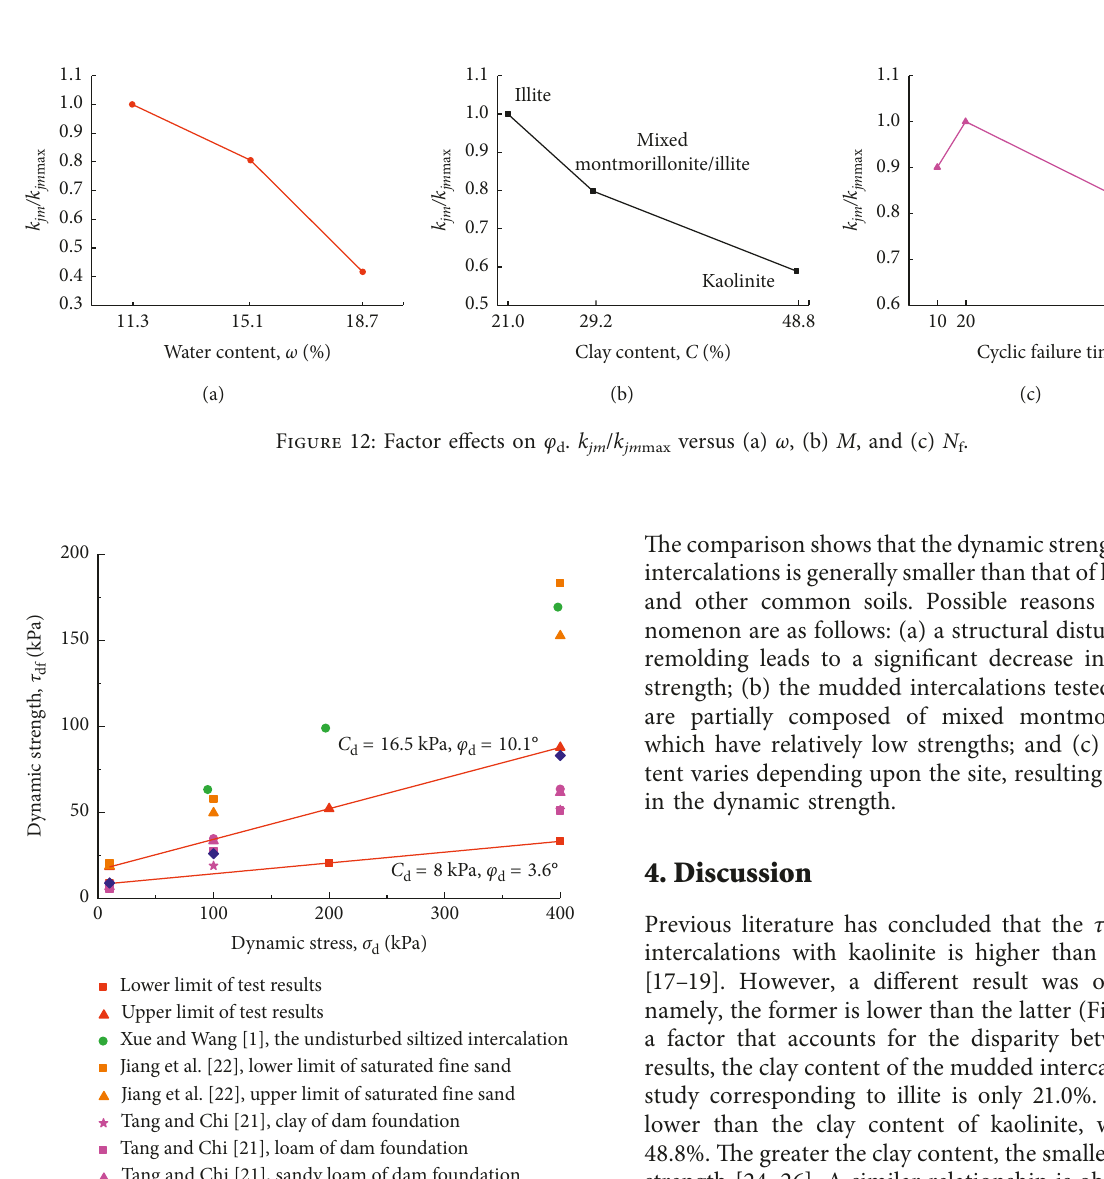
Figure 11: Factor effects on C d . k jm / k jm max versus (a) ω , (b) M , and (c) N f .